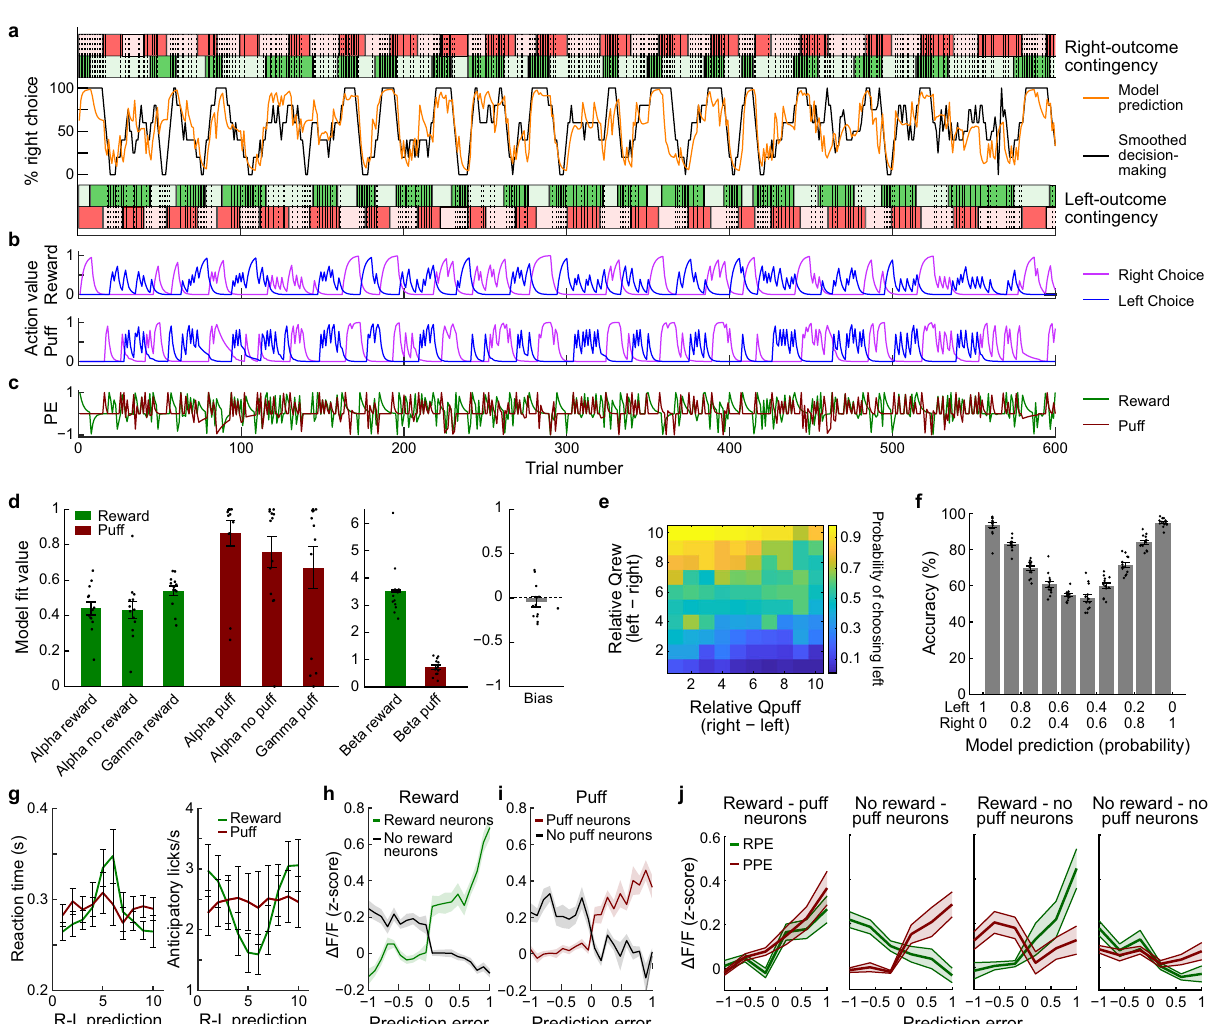
Fig. 4 Outcome neurons are modulated by RPE and PPE. a Session example. Action – outcome contingency is shown as colored blocks (reward: green; puff: red) for right (top) and left (bottom) choices. Dark and light red/green shading indicates, respectively, 80% and 0% probability of outcome delivery. Within blocks, solid lines indicate trials in which the outcome was delivered, and dotted lines indicate trials in which the outcome was not delivered. Middle lines show the smoothed decisions by mice (black) and model prediction (orange). b Estimated Q -values for the reward (top) and puff (bottom) for both actions for every trial. c RPE and PPE calculated for every trial by subtracting the Q -value of the chosen action from the outcome. d Average model parameters estimated by the RL model (alpha: learning rate for trials with reward/no reward and puff/no puff; gamma: outcome speci fi c forgetting rate; beta: inverse temperature; bias: directional bias) (mean±SEM, n = 13 mice). e Fraction of trials in which the mouse chose the left action as a function of relative reward Q-values and relative puff Q -values. f Accuracy as a function of the probability of left and right actions as predicted by the model (mean±SEM, n = 13). g Trial-by-trial model predictions correlated with reaction time (left) and anticipatory licking (right; n = 13 mice, data are mean±SEM). h Δ F/F response during outcome period was correlated with RPE in reward neurons (green, r = 0.89; p = 1e − 8, two-sided Pearson correlation) and in no-reward neurons (black, r = − 0.76; p = 0.026). Data shown represent mean±SEM. i Δ F / F was signi fi cantly correlated with PPE in puff neurons (red, r = 0.92; p = 0.0008, two-sided Pearson correlation), but not in no-puff neurons (black, n.s.). Data shown represent mean±SEM. j Activity of neurons that responded to both reward and puff outcomes (Fig. 3c) is modulated by RPE and PPE (reward – puff neurons: RPE: r = 0.68, p = 0.0051; PPE: r = 0.68, p = 0.0052; no-reward – puff neurons: RPE: r = − 0.82, p = 0.00017; PPE: r = 0.45, p = 0.009; reward – no-puff neurons: RPE: r = 0.88, p = 0.000016; PPE: r = − 0.11, p = 0.023; no-reward – no-puff neurons: RPE: r = − 0.40, p = 0.012; PPE: r = − 0.5; p = 0.050, two-sided Pearson correlation). Data shown represent mean±SEM. Source data are provided as a Source Data fi